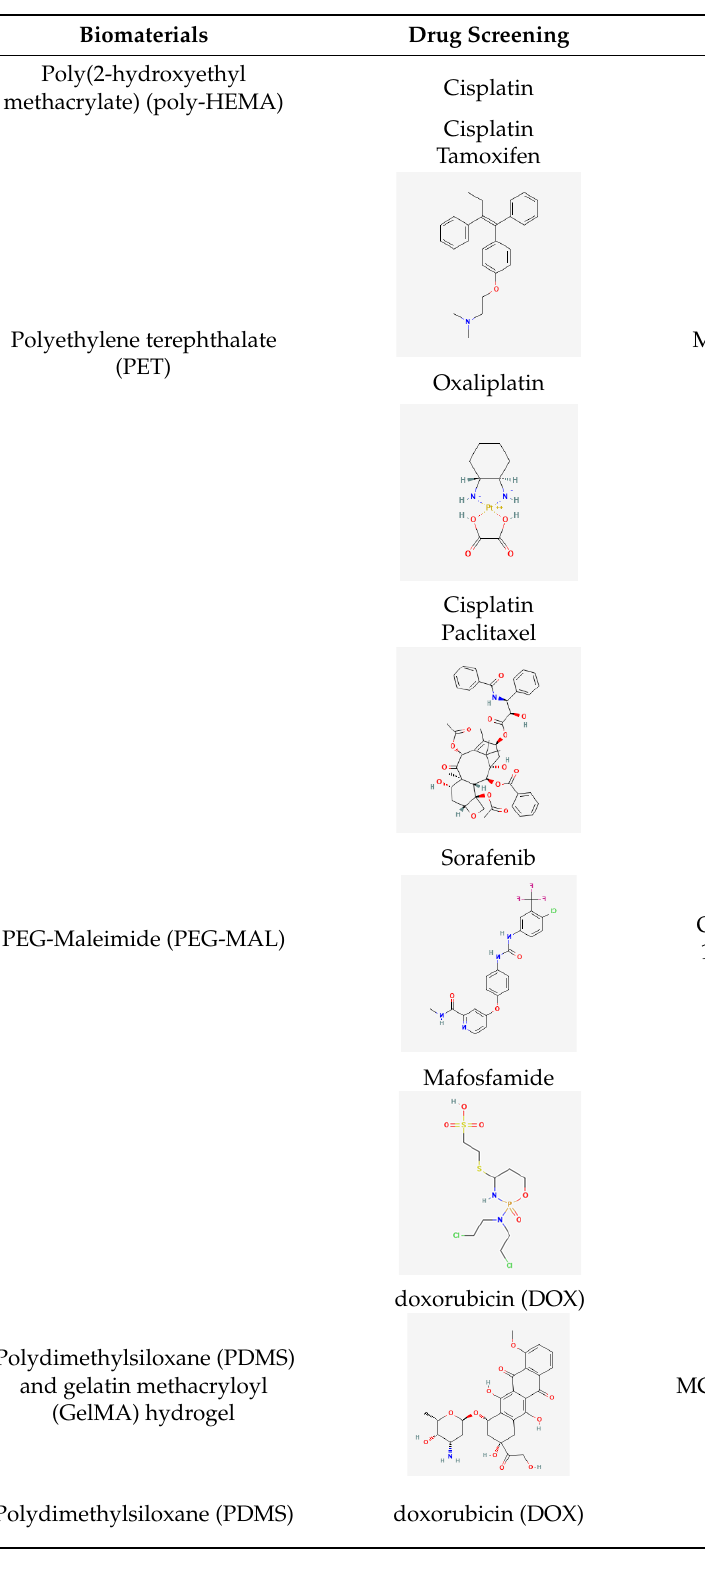
6 Table 1. Three-dimensional cell culture of cancer cells combined with biomaterials.